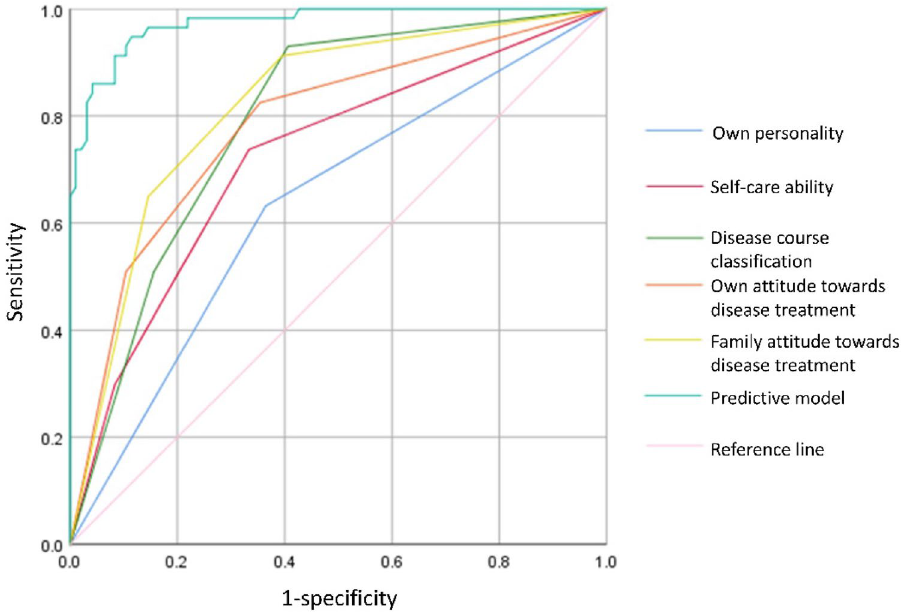
Figure 1. ROC curve of the predictive model and the various factors. The area under the ROC curve of the predicted model was